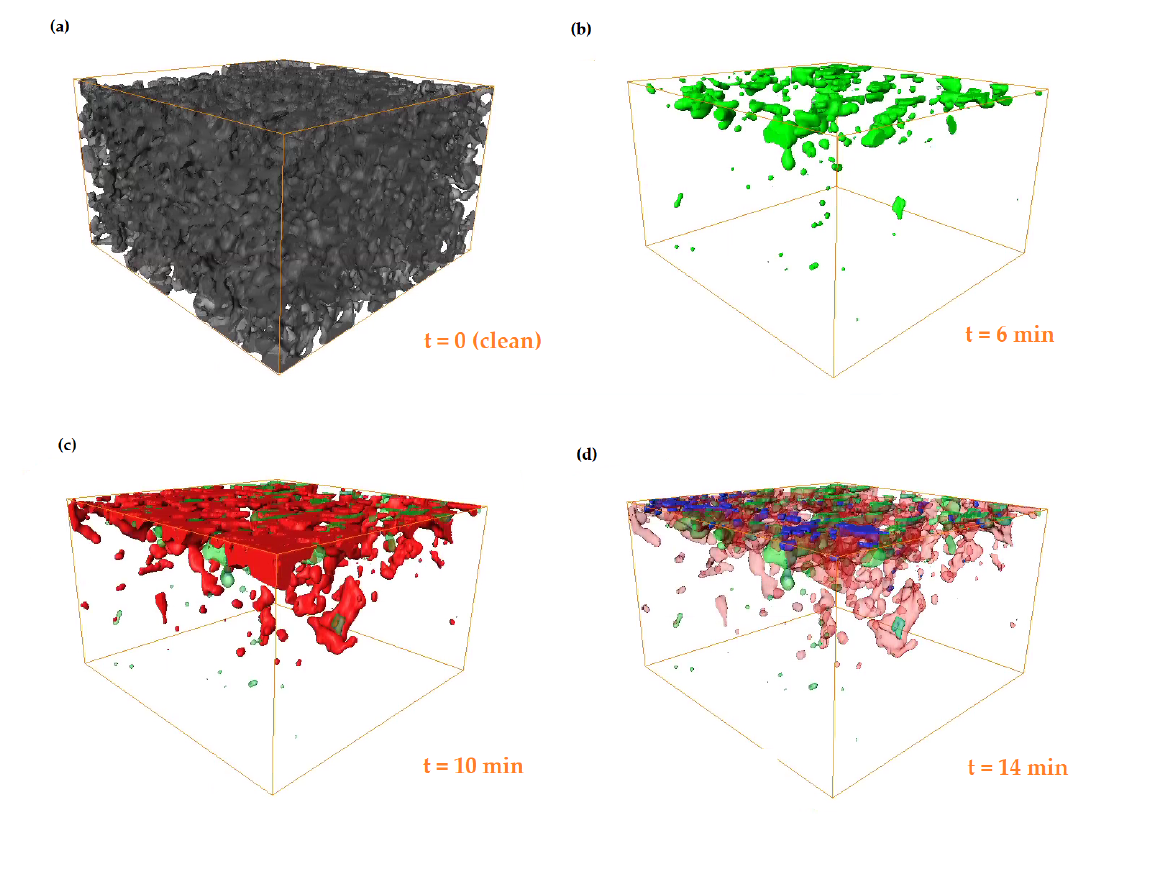
Figure 5. 480 × 480 × 295 µ m (300 × 300 × 184 pixels) micro-CT volume showing TiO 2 deposits in the pore space at different times during the filtration, the aerosol flow is from top to bottom. The volume is a quadrant from the REV indicated in Figure 6a. ( a ) t = 0 (showing the rendered filter phase only, shaded in grey), ( b ) 6 min (green), ( c ) 10 min (red) and ( d ) 14 min